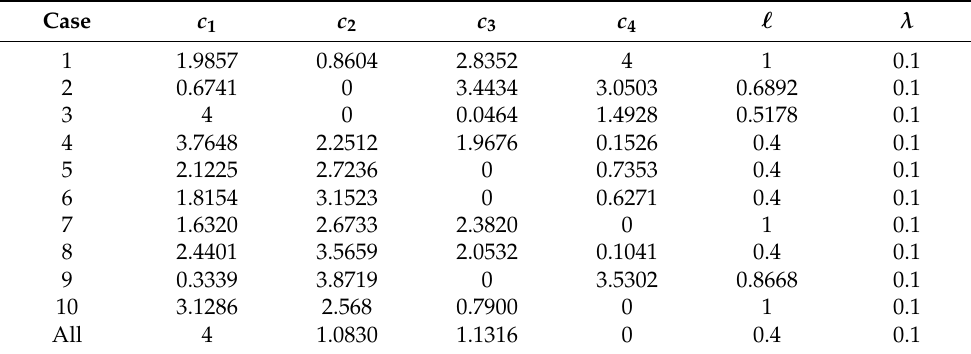
Table 3. Values of the hyper-parameter optimization using RBF ( (cid:96) = 1.0) as kernel.